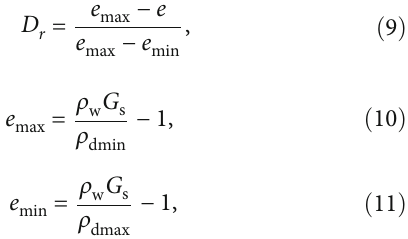
Figure 4: Grain size distribution curves of calcareous sands. Table 1: Physical properties of calcareous